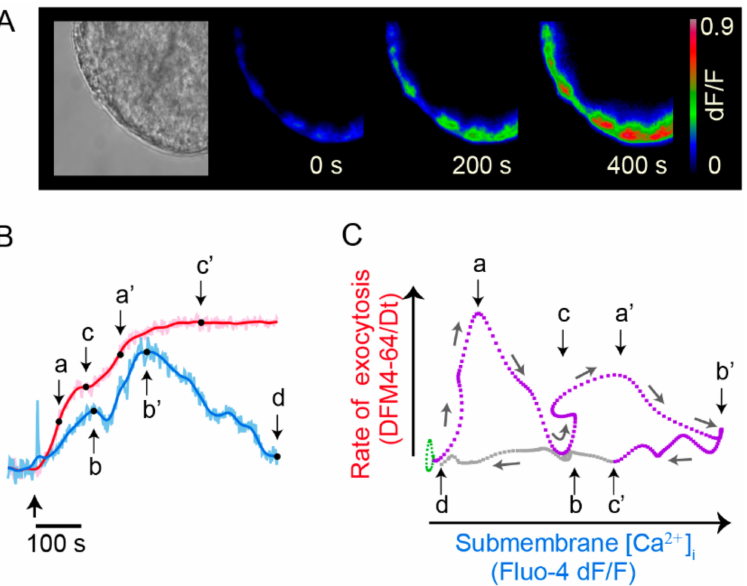
Figure 8. Exocytosis is maintained by a positive feedback loop. ( A ) Slow development of FM4-64 dye fluorescent spots during exocytosis upon 20 Hz train. Images were taken from spots in an equatorial plane of the soma in culture. ( B ) Kinetics of exocytosis (red) and calcium (blue) from simultaneous optical recordings. Exocytosis displays two sigmoidal steps, each corresponding to a vesicle cluster. a and a’ are the dynamic ranges of exocytosis; c and c’ are the plateaus indicating the end of exocytosis from each vesicle cluster. In the calcium signal the fast transient appears as a spike synchronized to stimulation (thick arrow). Following is the peripheral transient with two elevations, each correlating with an exocytosis bulk. The peaks of the calcium signal and b’ occur by the end of exocytosis. When exocytosis finishes the calcium levels return to rest. ( C ) State–phase diagram for the kinetics in C, indicating feedback loops between calcium and exocytosis. Each cycle reflects exocytosis from one vesicle cluster. Reproduced with permission from